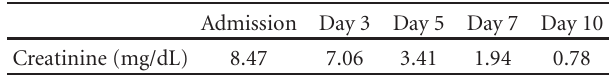
Table 1: Measurement of serum creatinine during